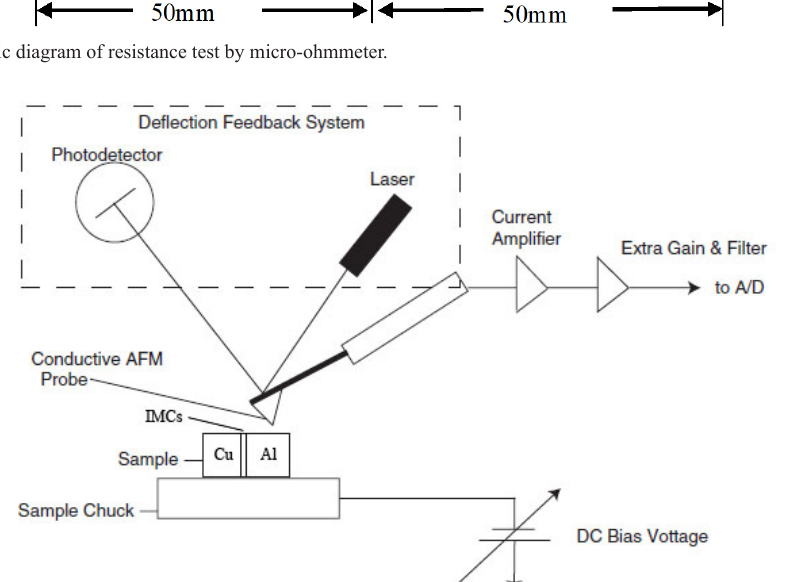
Figure 3. Schematic diagram of current map measurement by